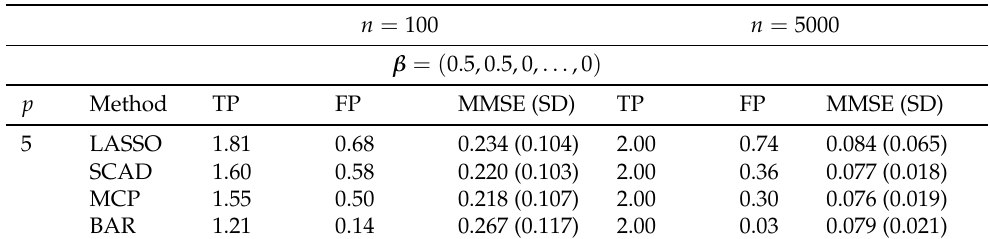
Table 4. Simulation results based on the joint selection of the tuning parameter and bandwidth for n = 100 or n = 5000 with p = 5. n = 100 n = 5000 β = ( 0.5,0.5,0, . . . ,0